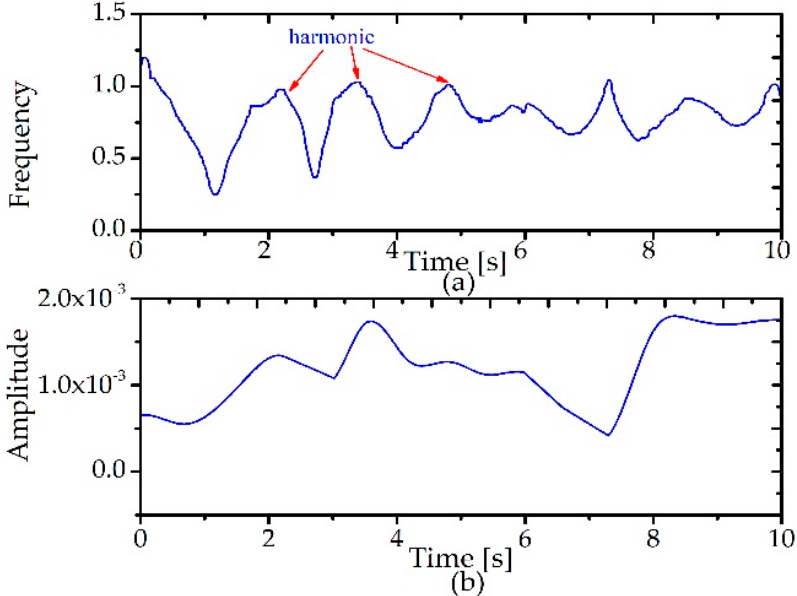
Figure 10. The IA and IF by HT for reconstructed oscillations after implemented EMD method, ( a ) the IF for oscillations, ( b ) the IA for oscillations in the simulation.